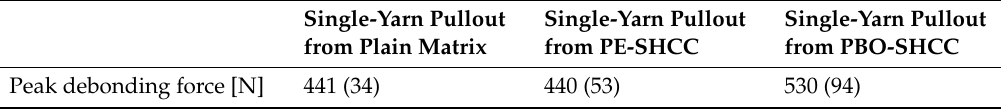
Figure 9. Quasi-static force-slip relationships of single carbon yarns pulled out from: ( a ) plain matrix; ( b ) PE-SHCC; ( c ) PBO-SHCC; and ( d ) representative force-slip relationships for different composites up to a slip extent of 0.5 mm. Table 6. Peak debonding forces in quasi-static pullout tests with three different matrices (average values; standard deviations are given in parentheses).